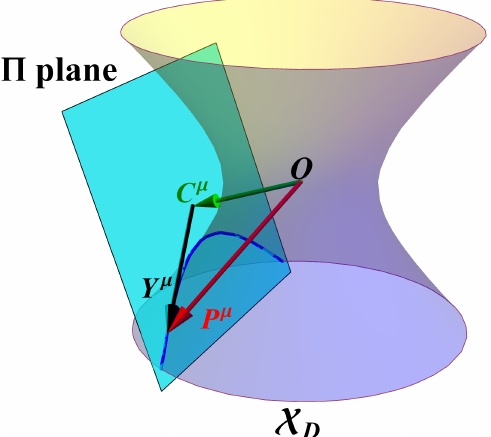
Figure 6 . This figure depicts D dimensional AdS hypersurface X D embedded in D +1 dimensional flat spacetime E D +1 . The blue curve slows the hyperbolic trajectory of a particle which is a conic section between two dimensional Π plane and X D . Here C µ is orthogonal to the Π plane and Y µ is contained in that plane. P µ is a position vector of point P . The base point of this vector is the origin O of E D +1